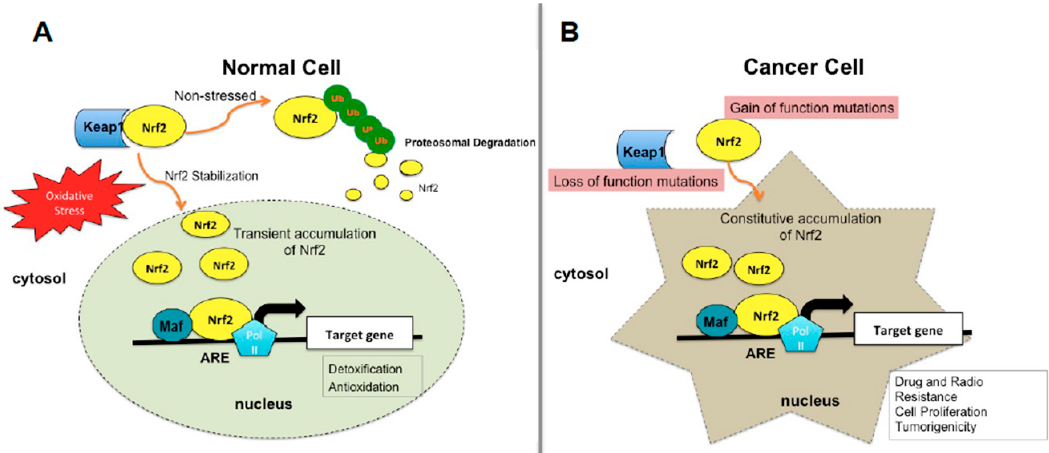
Figure 1. Nrf2 status in normal and cancer cells. ( A ) In a normal cell, under normal conditions Keap1 inhibits transcriptional activity of Nrf2 via ubiquitination and proteasomal degradation, under stress conditions Keap1 and Nrf2 interaction does not occur, causing Nrf2 stabilization and accumulation in nucleus, which in turn induces cytoprotective gene expression. ( B ) In a cancer cell, somatic mutations in NRF2 (gain of function mutations) and KEAP1 (loss of function mutations) result in constitutive activation of Nrf2 inducing expression of genes related to tumorigenity. Nrf2, nuclear factor erythroid 2-related factor 2; Keap1, Kelch-like ECH-associated protein 1; Maf, small musculoaponeurotic fibrosarcoma protein; Pol II; Polimerase II; ARE: Antioxidant response element